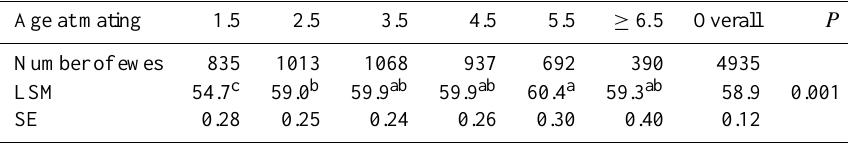
Table 1. Premating live weights (kg) of Central Anatolian Merino ewes by age.